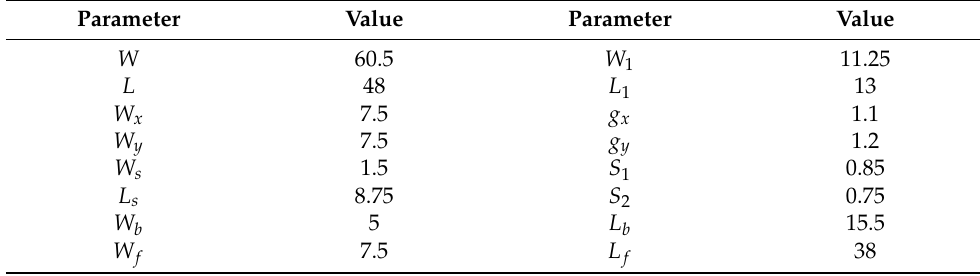
Table 1. Parameter values of the wideband antenna shown in Figure 1 (unit: mm).